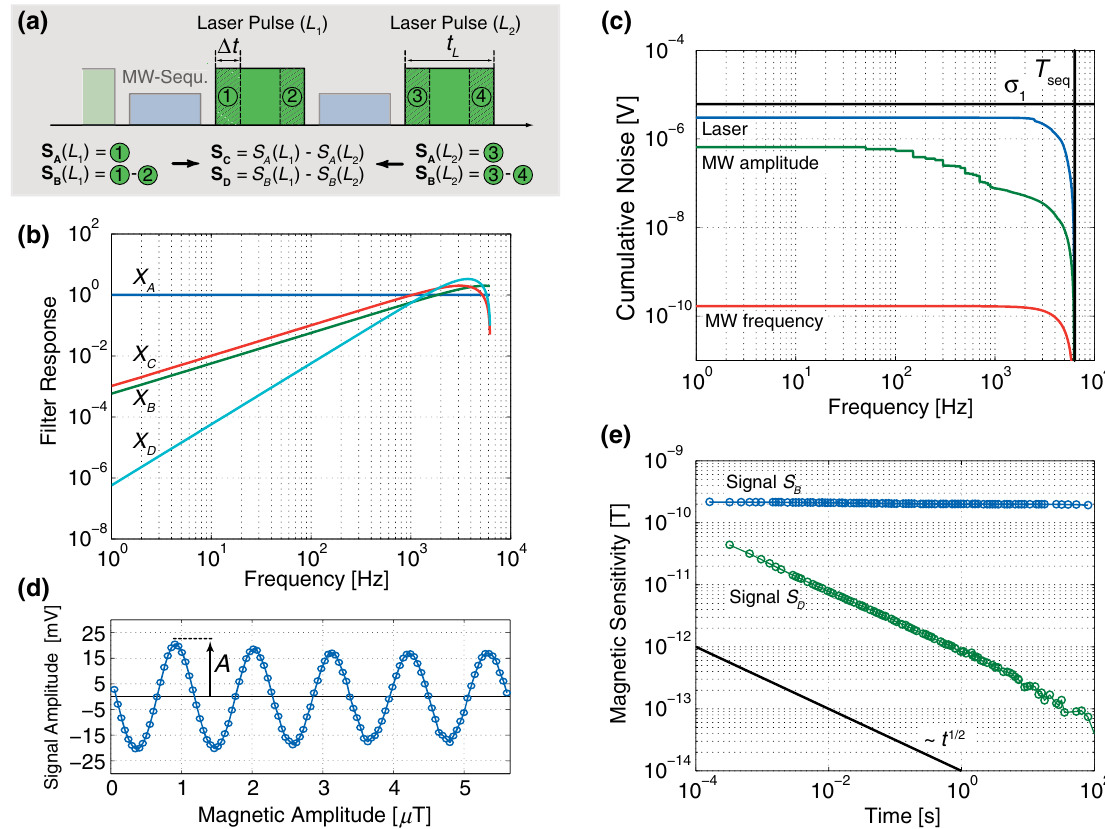
− S ) represent different ways of taking the signal from A D − S . (c) Cumulative, sequence-filtered noise of laser A D . The black horizontal line indicates single- D